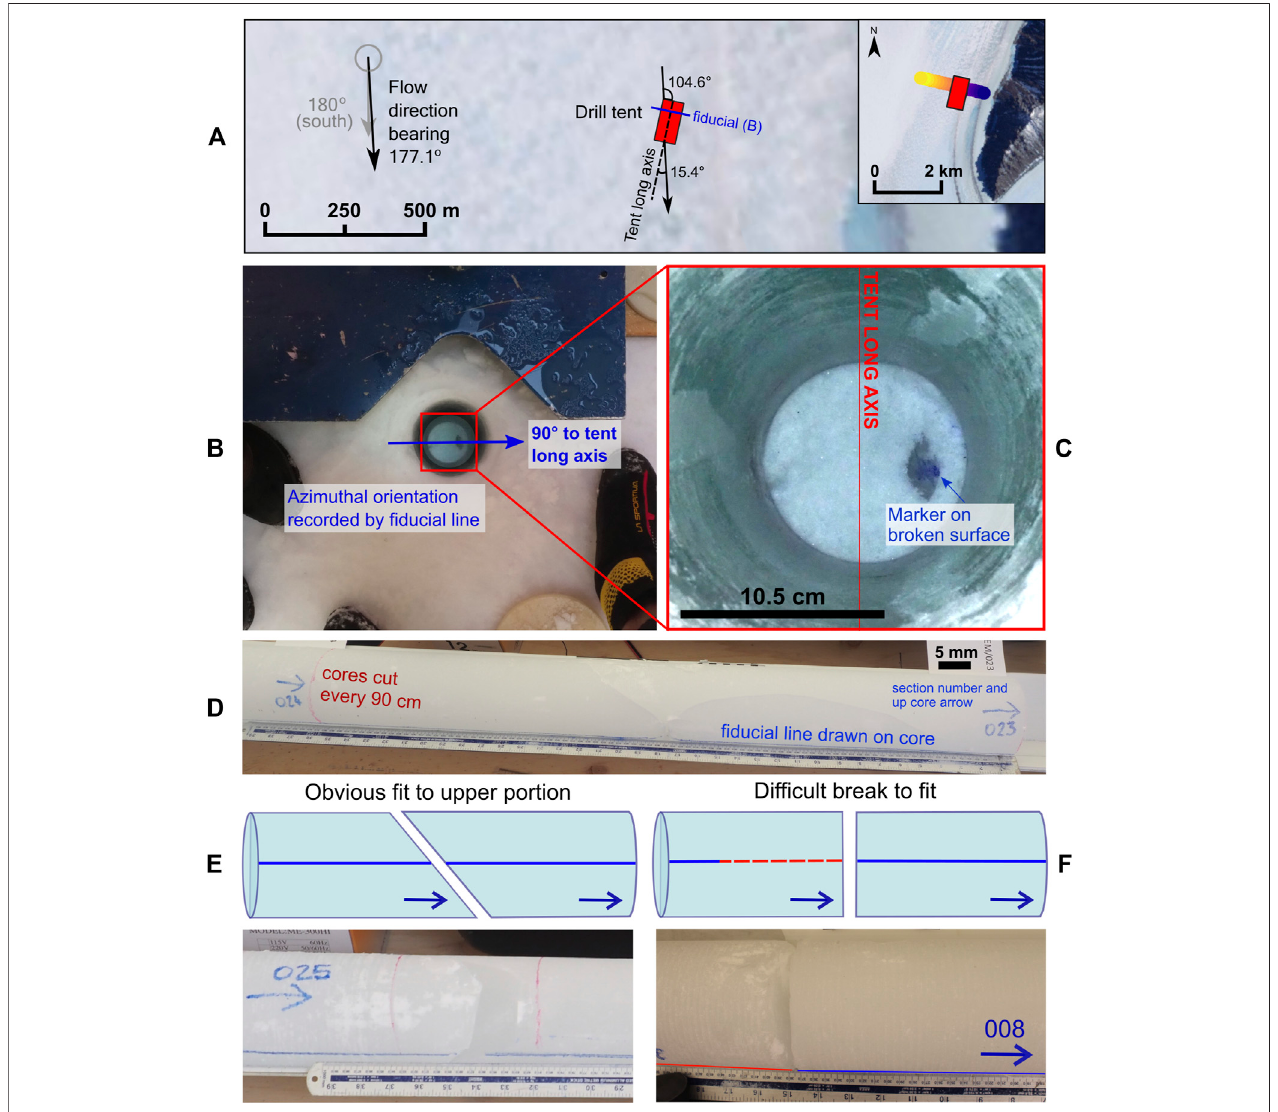
FIGURE 2 | Core collection and processing with care to preserve azimuthal orientation. (A) GNSS data gives a fl ow direction azimuth of 177.1 ° fl owing south. This gives an angle of 15.4 ° between the coring tent long axis and fl ow. (B) Initial fi ducial mark drawn in top 1 – 2 m during core extraction. (C) Orientation of the fi ducial mark relative to the core tent long axis. (D) Core processing before packaging and storage. Core sections either fi t together obviously (E) or with dif fi culty (F) and are marked with the fi ducial line.